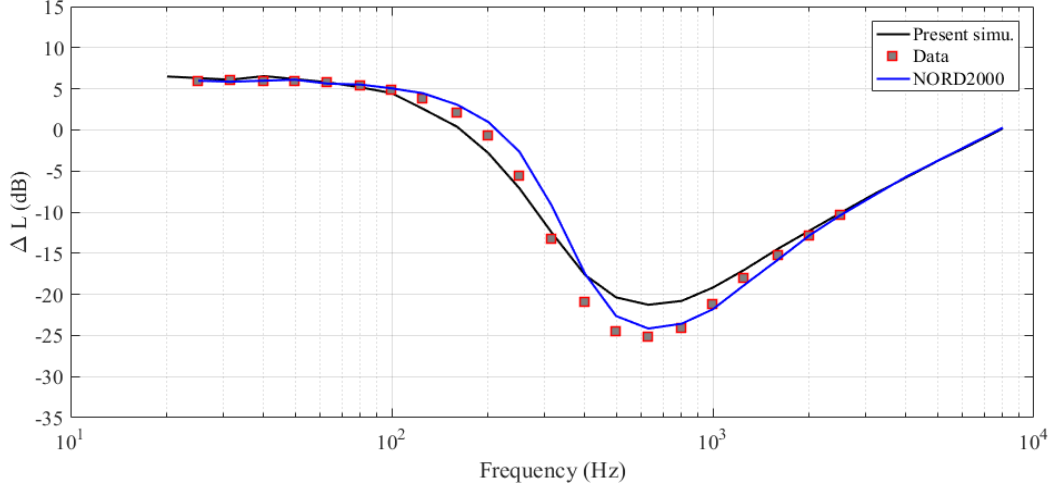
Figure 4. Comparisons of the RSPL in 1/3-octave bands.